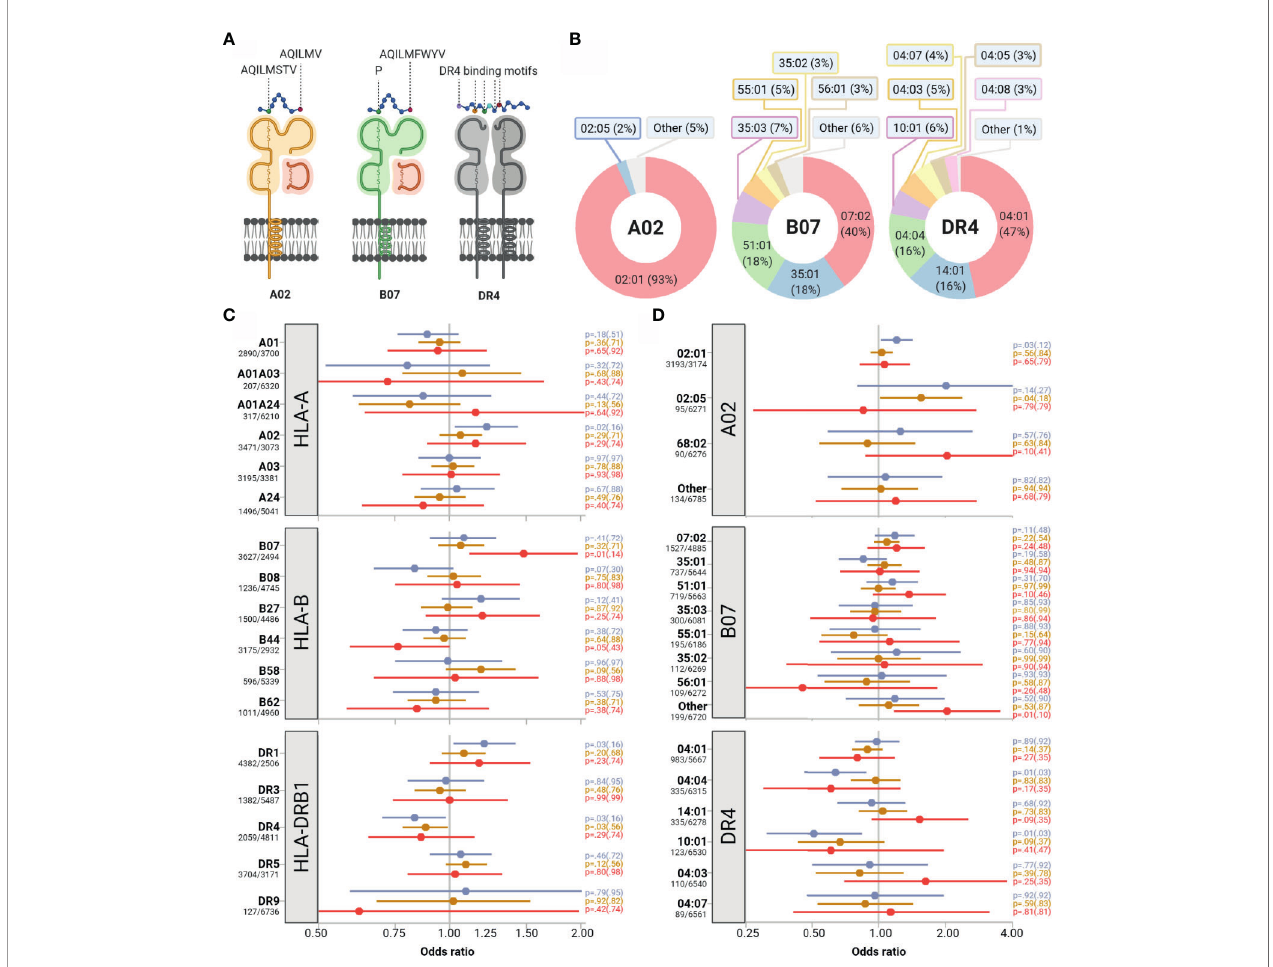
FIGURE 1 | Impact of selected HLA supertypes and allotypes on COVID-19 severity. (A) Assignment of HLA allotypes into HLA-supertypes based on peptide binding characteristics. Supertype-speci fi c amino acids at peptide anchor positions 2 and 9 are indicated with capital letters exemplary for supertypes A02 and B07. (B) The relative proportions of HLA alleles constituting supertypes A02, B07, and DR4 are depicted as doughnut charts. (C, D) Impact of supertypes and single alleles on symptomatic infections (blue), severe respiratory symptoms (orange) and respiratory hospitalizations (red). Point estimates for odds ratios (represented as colored dots) and corresponding 95% con fi dence intervals (represented by colored bars) illustrate the effects of presence versus absence of supertypes (C) and allotypes (D) . Absolute numbers of patients with presence/absence of the supertype/allotype are provided on the left side. p-values of Wald tests and in brackets adjusted p values for multiple testing are given on the right